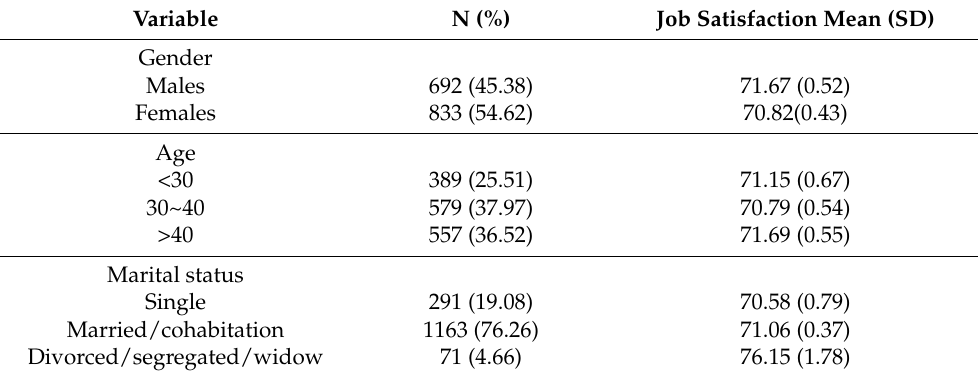
Table 1. Demographic characteristics of sample and distributions of job satisfaction (N = 1525).